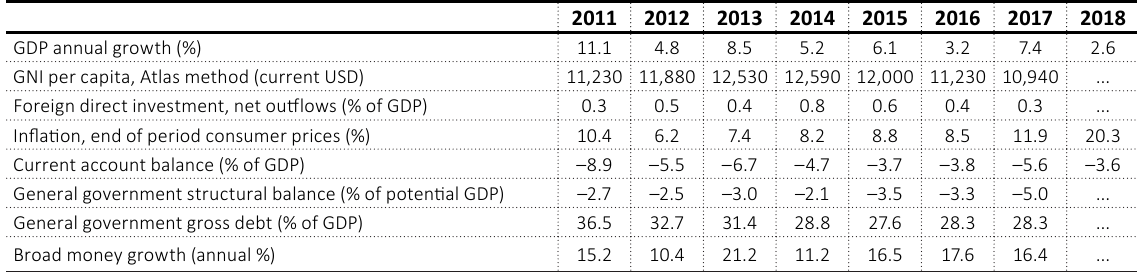
Source: World bank,